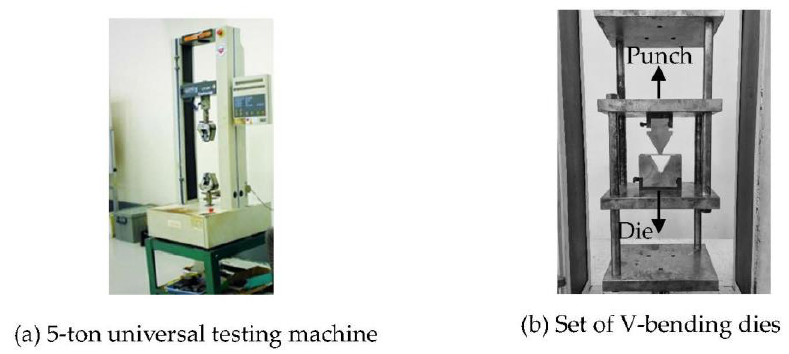
Figure 4. Press machine and set of V-bending dies.